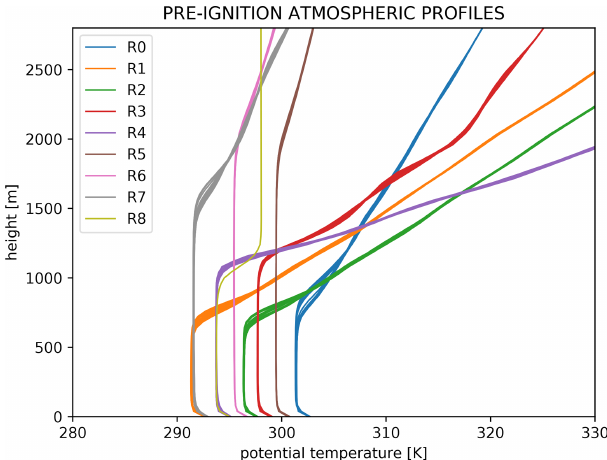
Figure 1. Pre-ignition potential-temperature profiles (stability con- dition R ). Colors correspond to initial soundings used for model